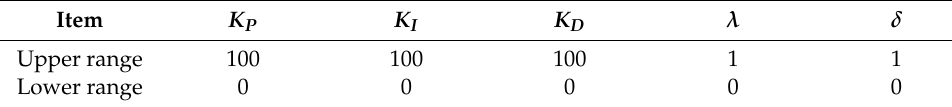
Figure 10. Benchmark test system for three scenarios. Table 5. Constraints of the FOPID-PODC parameters .